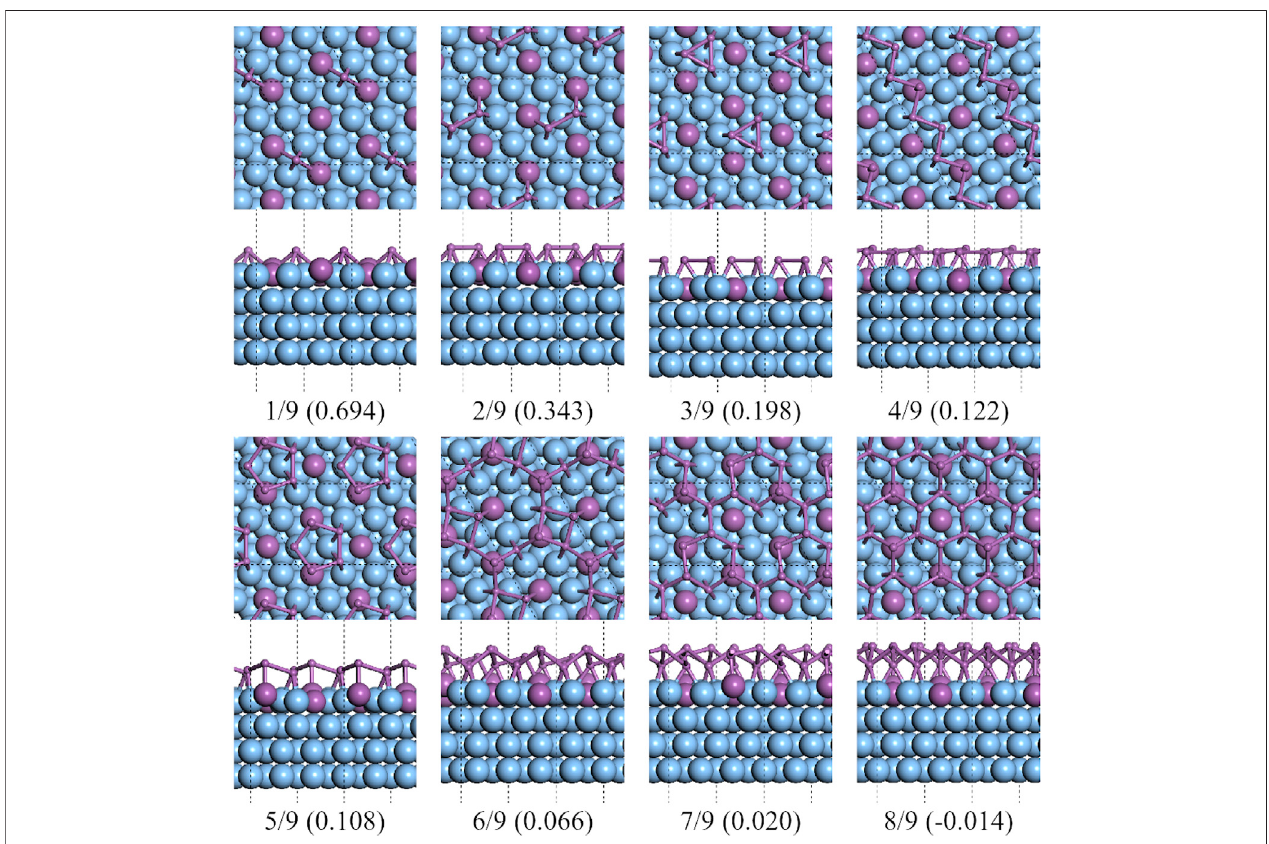
FIGURE 10 | Top and side views of the lowest formation energy favorable con fi gurations of antimony adsorbed on the 3×3 Ag 2 Sb/Ag (111) substrate.